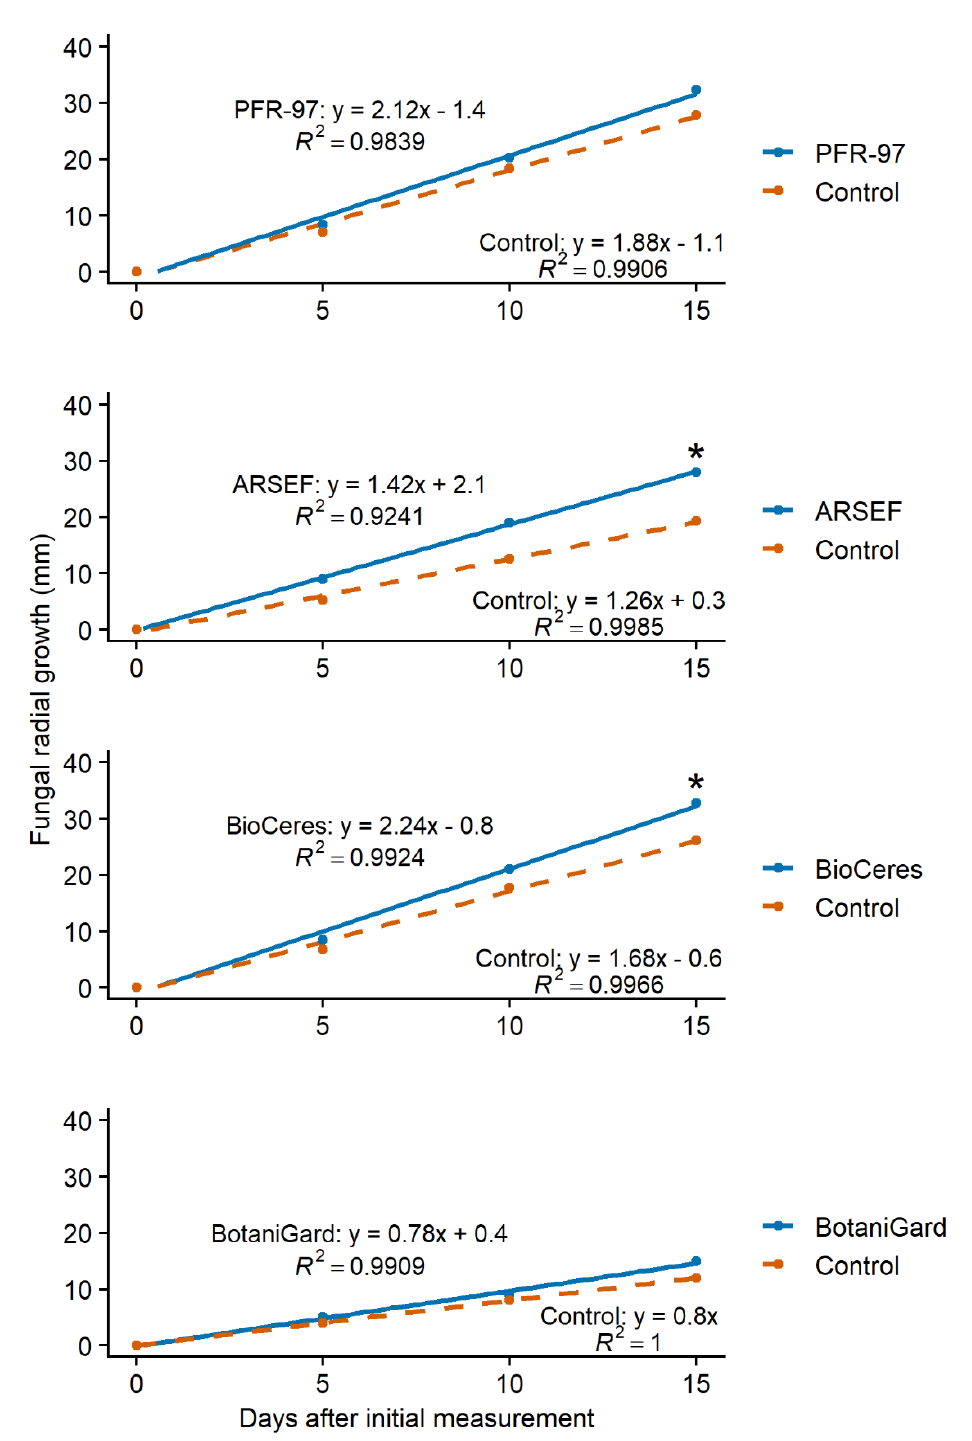
Figure 4. Linear models of fungal radial growth for four entomopathogenic fungal products grown on PDA with 50% (PFR-97 and BioCeres) or 25% (ARSEF and BotaniGard) concentration of turnip leaf extract compared to its control treatment over a 15-day observation period. Models for PFR-97 and BioCeres are based on 50% leaf extract concentration; models for ARSEF and BotaniGard are based on 25% because radial growth was fastest at this concentration. Asterisk (*) above a line endpoint represents significance between treatment and control linear models (Student’s t -test, p < 0.05).